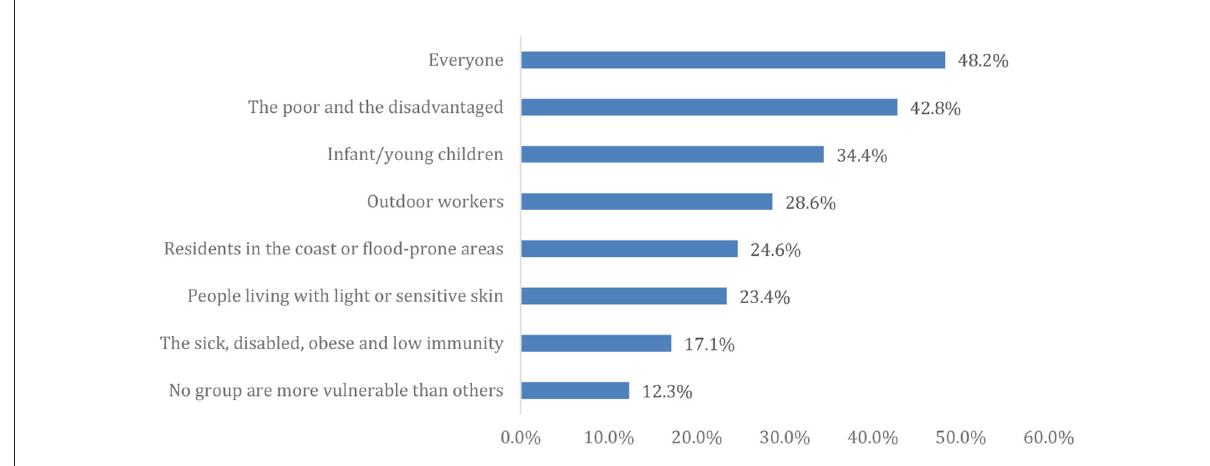
FIGURE1 More vulnerable people to the effects of global warming/ climate change.